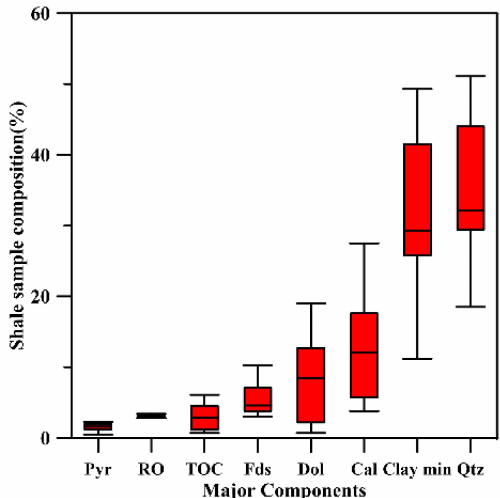
Figure 3. Effectiveness analysis diagram of mineral component test results.